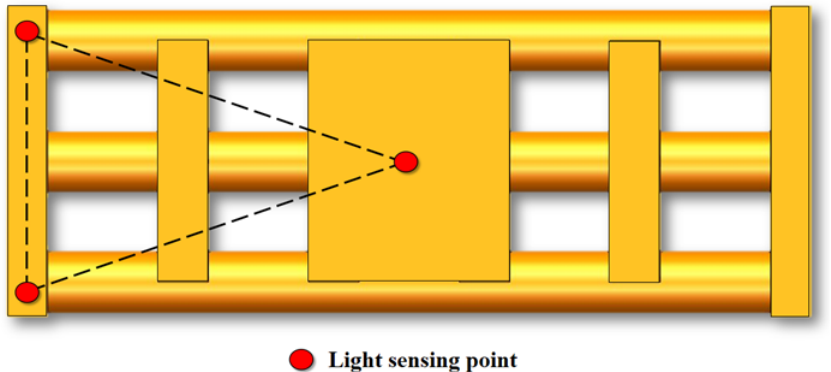
Figure 11. Schematic diagram of light sensing point layout of 4# module.